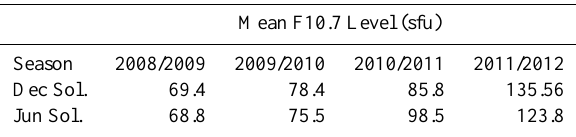
Table 1. The mean F10.7cm flux. The December solstice season in 2008/2009 spans from late November 2008 through February 2009. The June solstice in the same column is for 2009, with similar ranges for the remaining